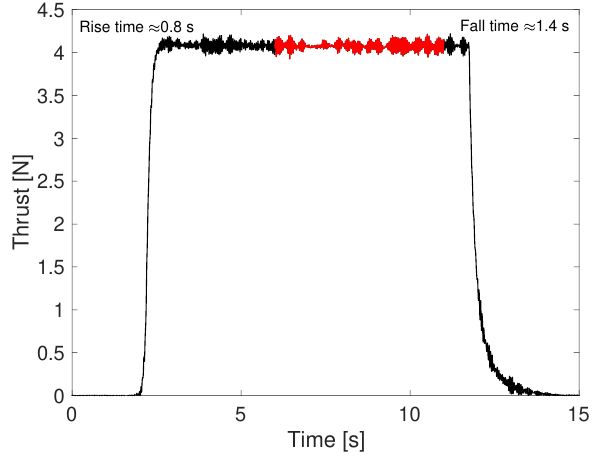
Figure 6. Typical actuator step response of 6000